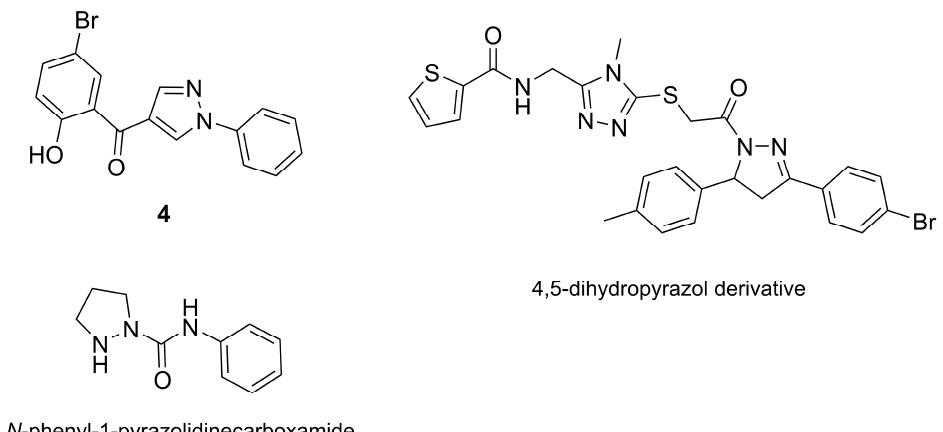
Figure 6. Structures of three selected compounds from those occuring in the methanol extract obtained from the whole plant of R. apiculata , which include a pyrazole derivative, (5-bromo-2-hydroxy-phenyl)-(1-phenyl-1 H -pyrazol-4-yl)ketone ( 4 ), a dihydropyrazole derivative, and a pyrazolidine derivative.